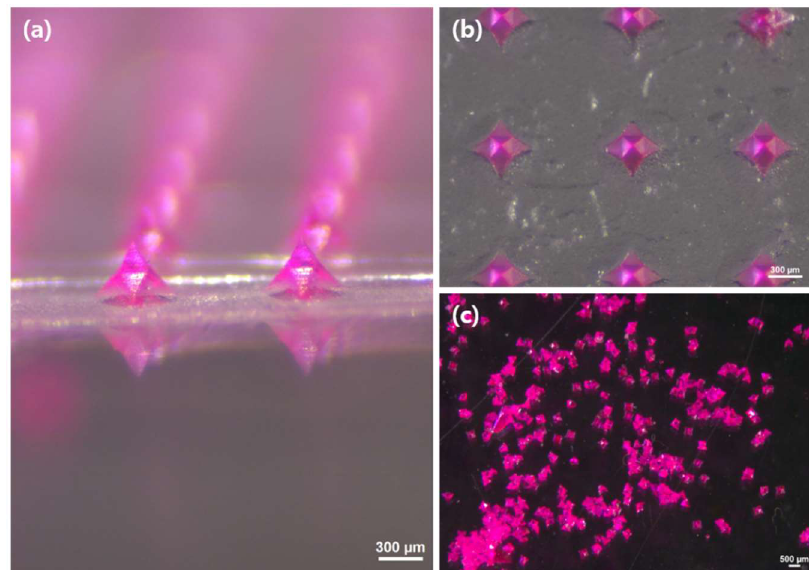
Figure 3. MLP array loaded with SRB ( a ) observed by stereo microscopy. The array contained 121 MLPs (11 × 11) in an area of 1 cm 2 . The MLPs were ( b ) removed from the h-PDMS mold by peeling off the PMMA film. The film was then ( c ) dissolved in ethyl acetate, and the freed MLPs were collected .